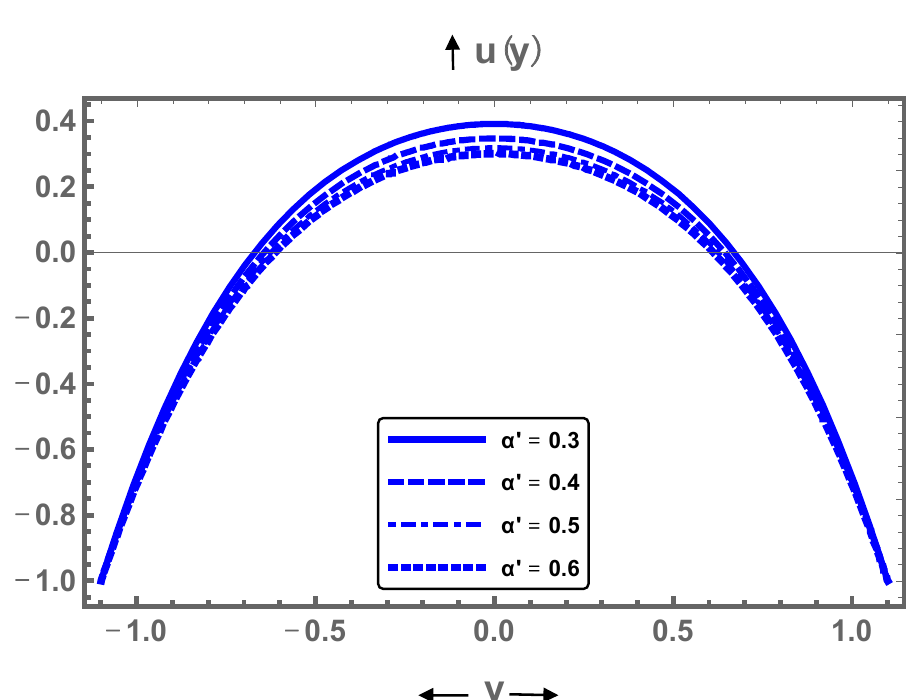
Figure 14. Display of axial velocity for different values of m .